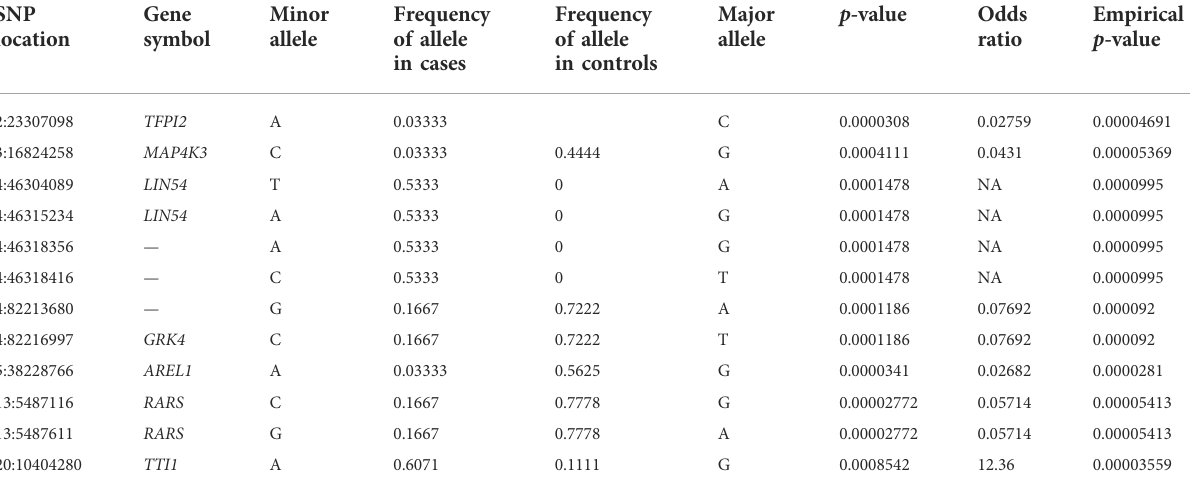
TABLE 4 SNPs associated with FHS in